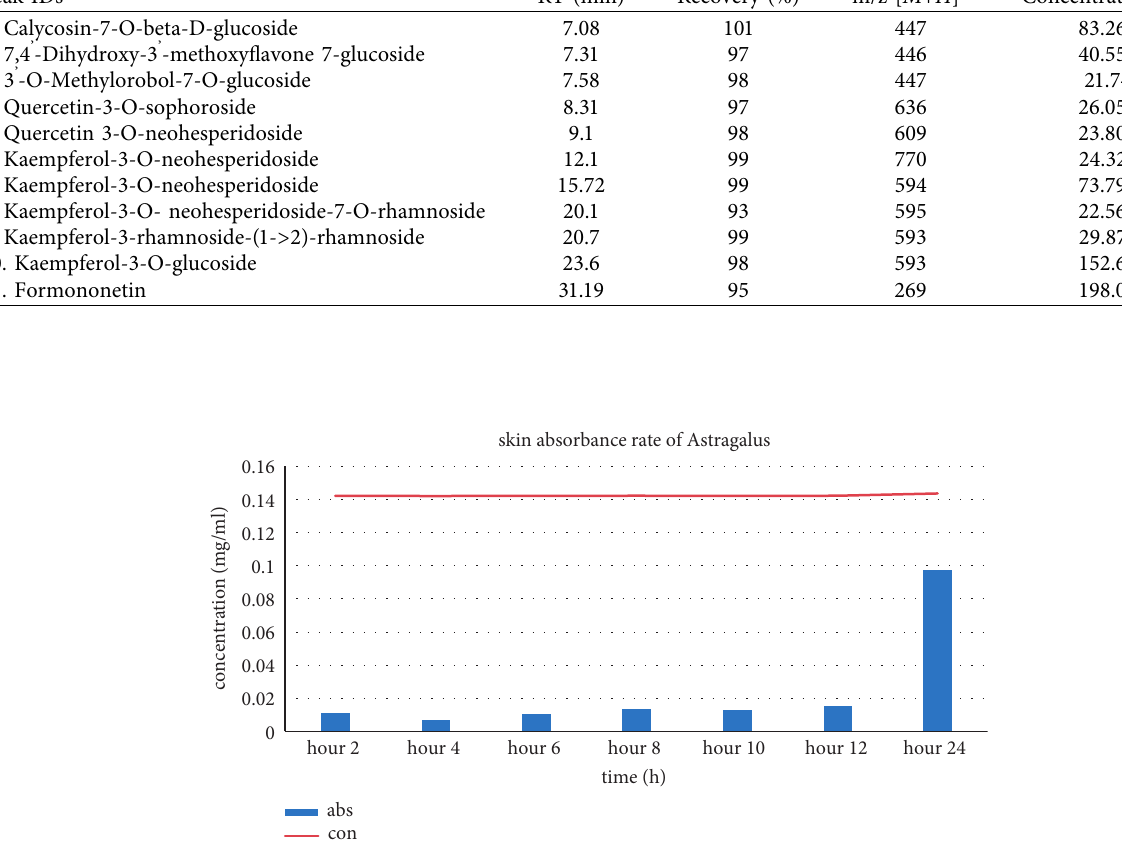
Figure 3: Skin absorbance ratio. The orange line shows the concentration of RFF formula penetrating the membrane during 24 h.